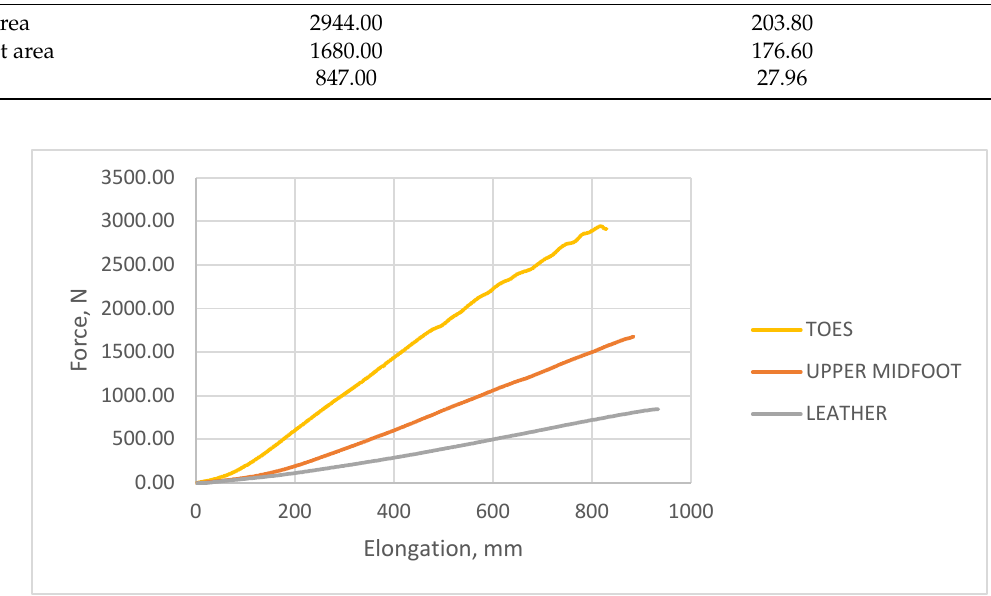
Figure 9. The tensile strength results for the selected footwear materials.